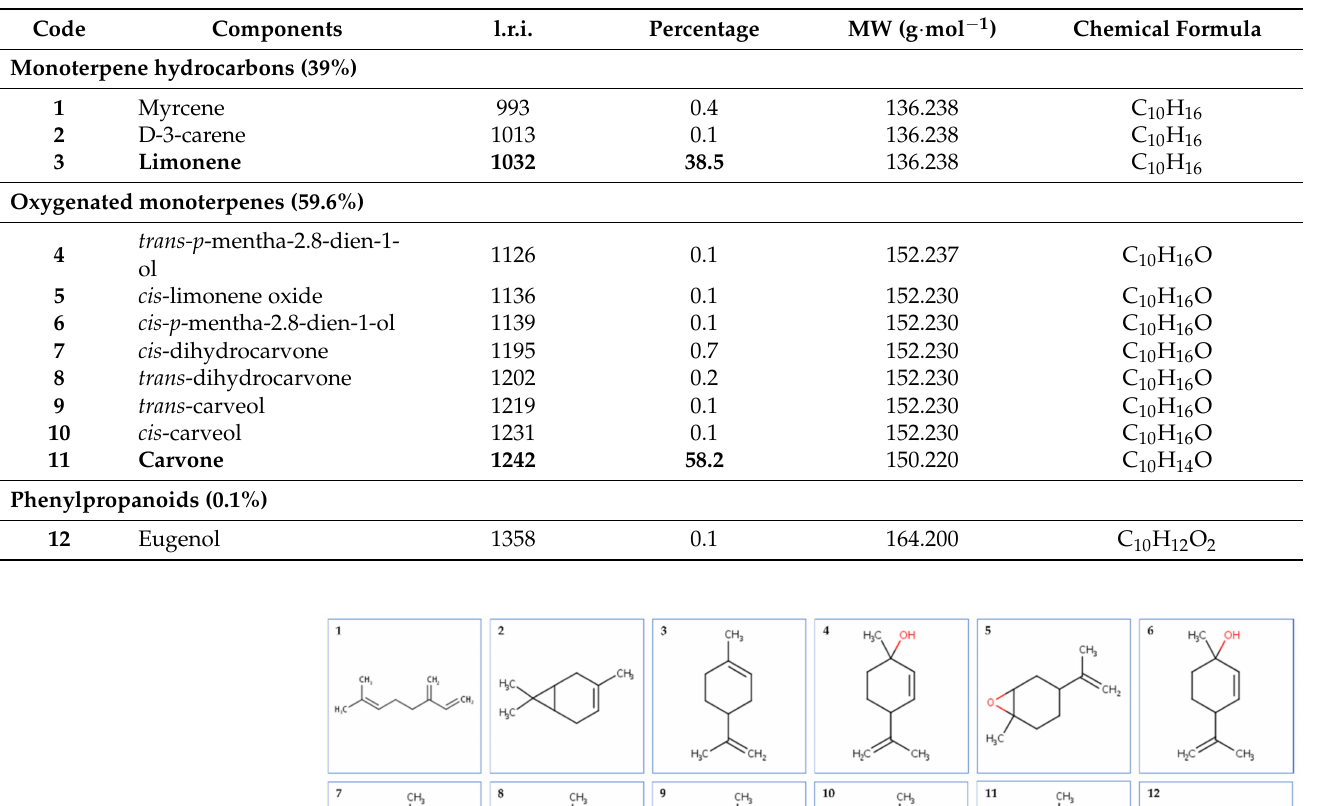
Table 1. Chemical composition of Carum carvi L. (seeds) EO. l.r.i.: Linear Retention Index.